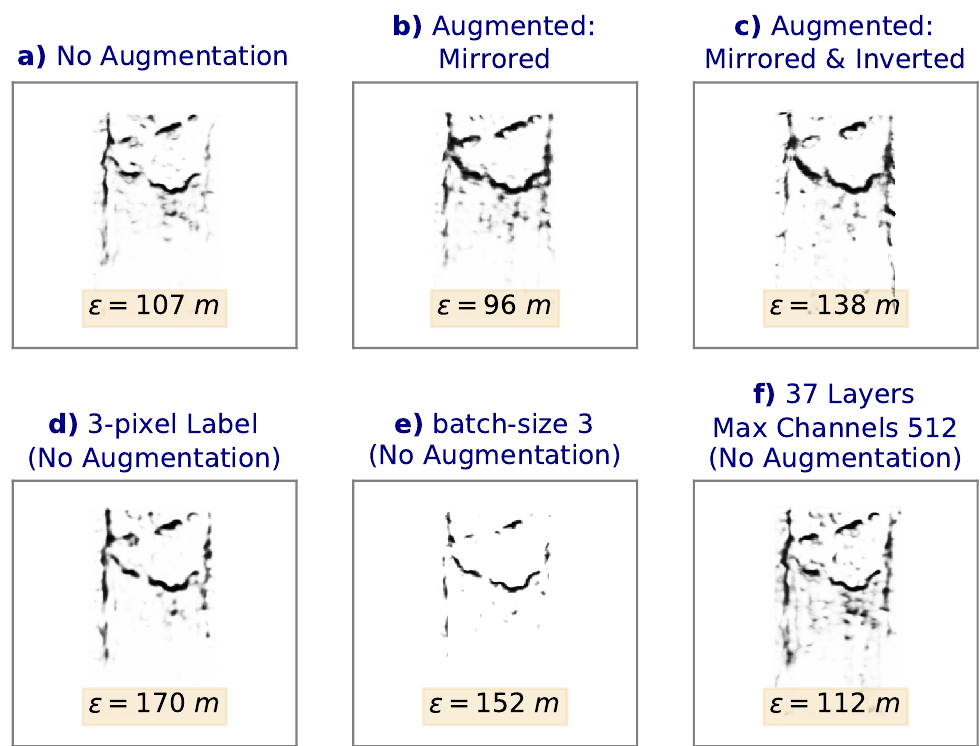
Figure 4. A comparison of raw outputs for various architecture and training configurations of the NN ( a–f ). ε represents the mean deviation from the true front for each case. Note the best results presented in the Results section correspond to Panel ( b